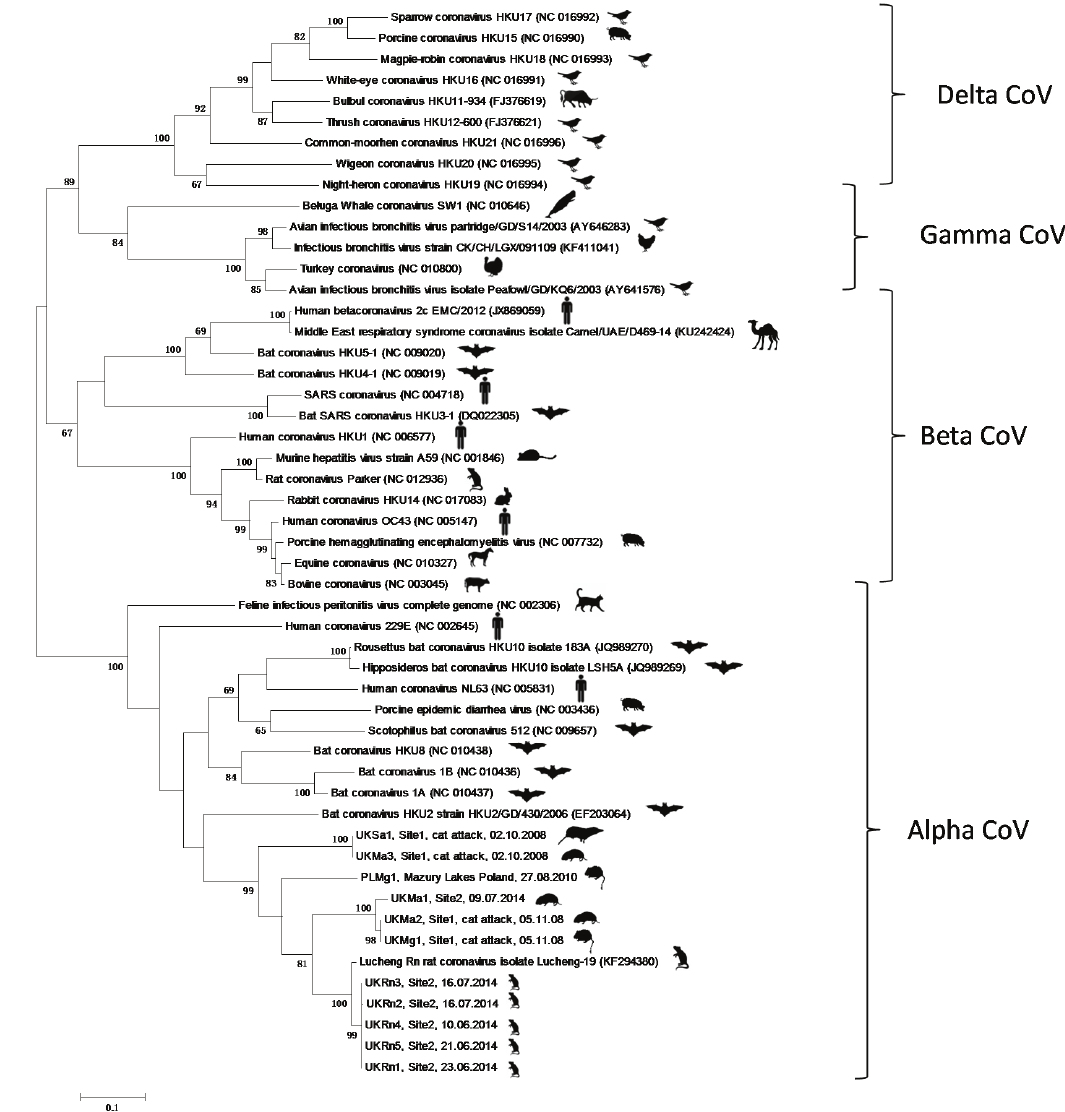
Figure 2. Maximum likelihood phylogenetic analysis of coronavirus partial ORF1ab gene sequences, corresponding to positions 8331-8960 on the Lucheng Rn isolate (Genbank Accession number KF294380. Novel coronavirus sequences obtained from UK-resident Rattus norvegicus (UK Rn ), Microtus Agrestis (UK Ma ), Sorex araneus (UK Sa ) and Poland-resident (PL Mg ) or UK-resident (UK Mg ) were analysed alongside reference sequences representing the four different coronavirus genera. Reference sequences are indicated by their Genbank Accession Number. Branch lengths are drawn to scale: the bar indicates 0.10 nucleotide substitutions per site. Numbers above individual branches indicate the percentage that that branch was found in 1000 bootstrap replicates; only percentages >60 are shown.